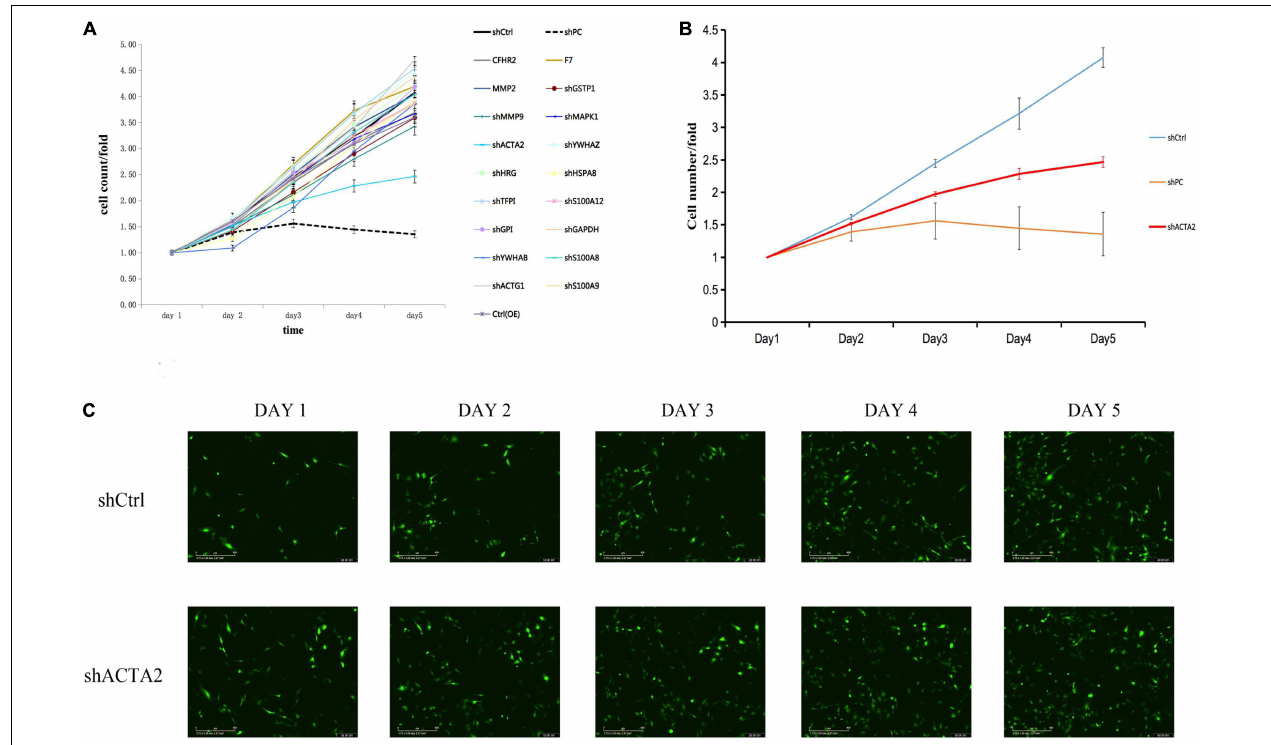
FIGURE 2 | HCS screening identified ACTA2 as a critical gene in promoting VM proliferation. (A,B) A total of 20 genes were selected for validation by high-content screening. PC: positive control siRNA targeting b-actin. (C) Representative fluorescence images of high-content siRNA screening for